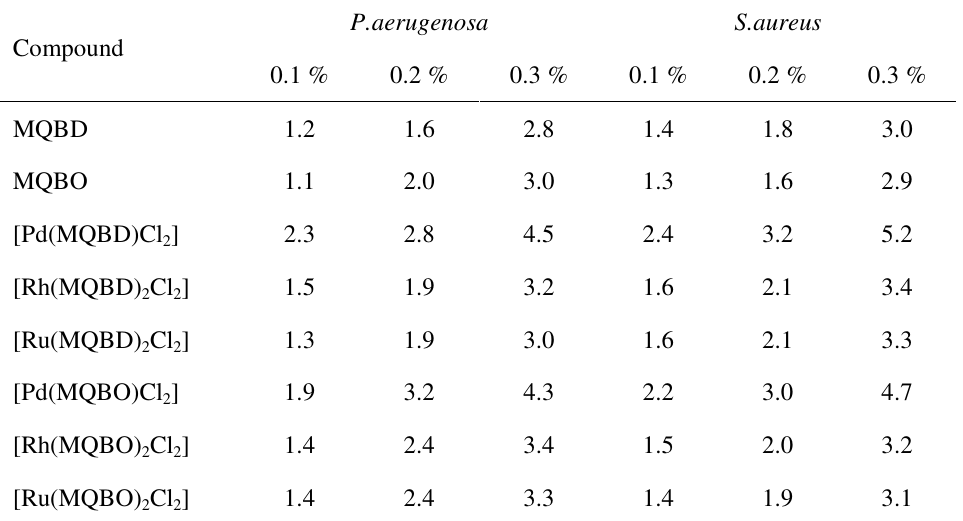
Table 3 . Inhibition zone of bacterial growth (mm)